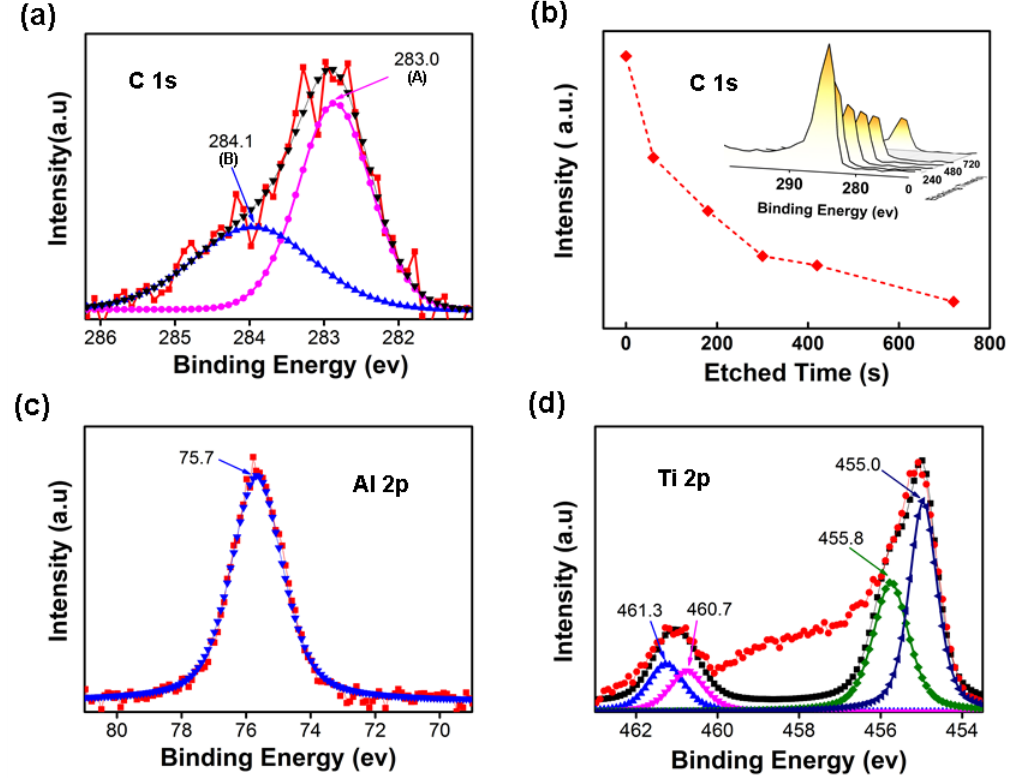
Figure 5. ( a ) C 1s spectrum for the carbon contained in the as-carburized steel; ( b ) relative carbon intensity against the depth (etched time) profile in the as-carburized steel. ( c ) Al 2p spectrum for the carbon contained in the as-carburized steel; and ( d ) the Ti 2p spectrum for the carbon contained in the as-carburized steel.